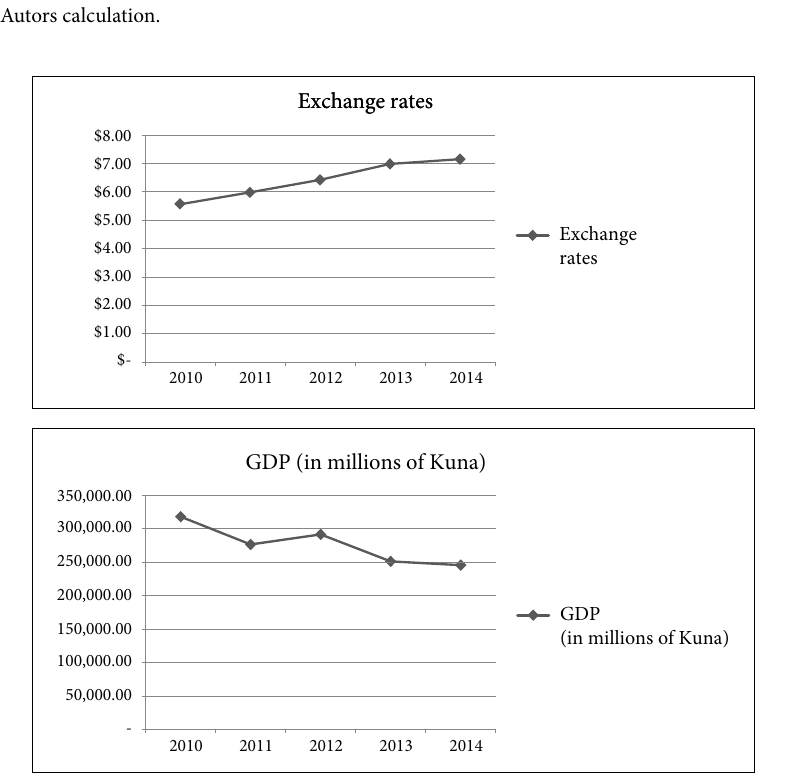
Fig. 2. kuna exchange rate depreciation scenario impact on GDp. Source: autors calculation